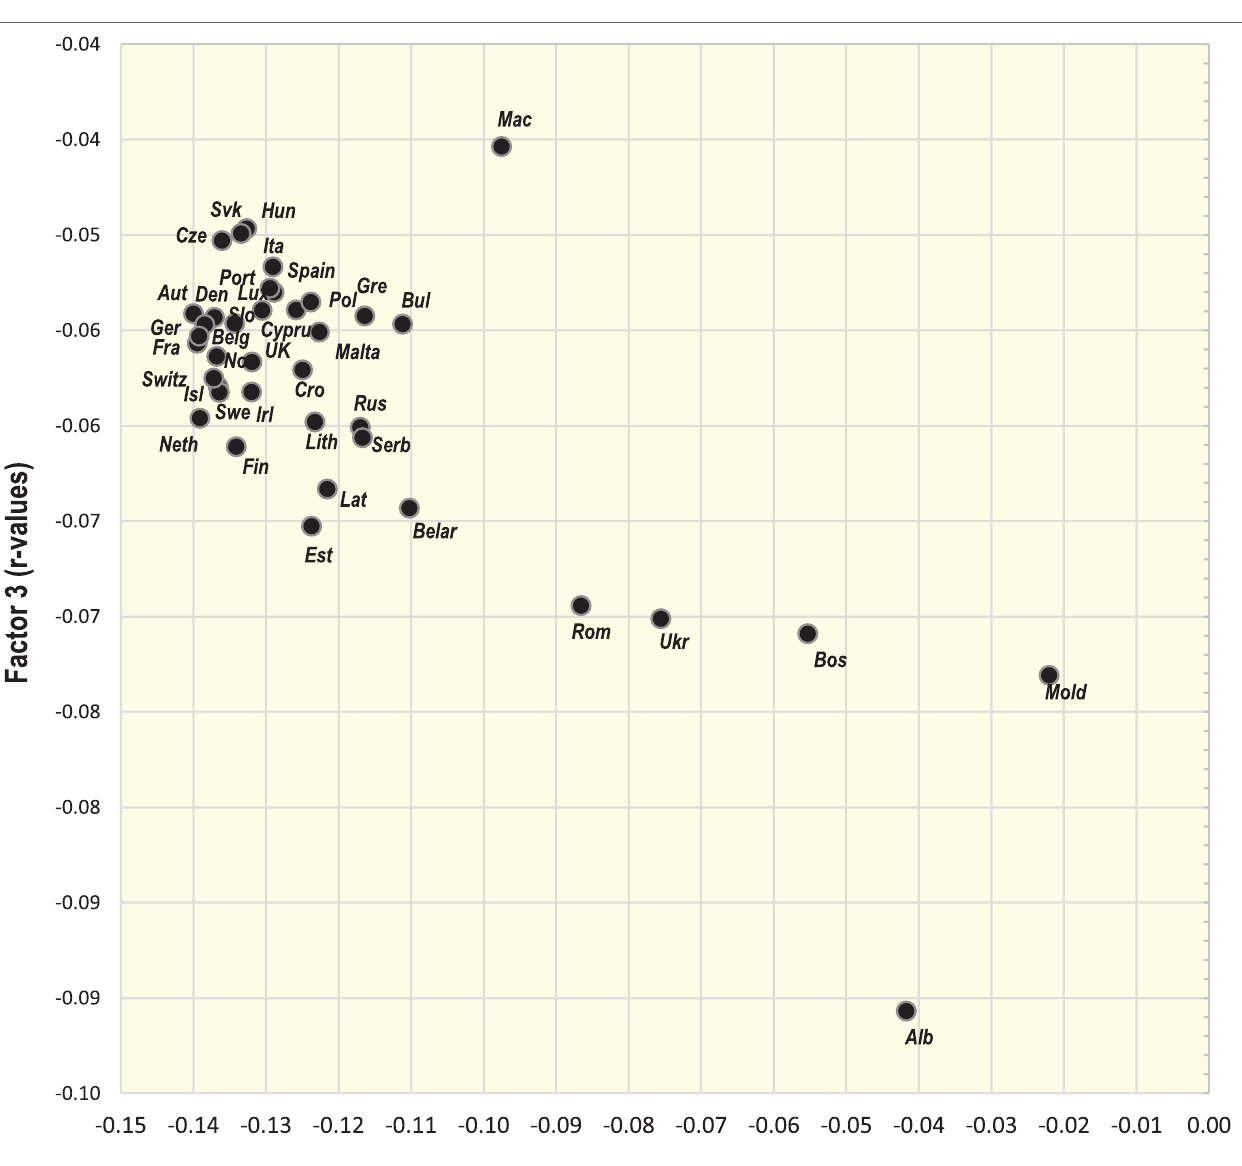
FigUre 10 | Projection of 39 countries on the factor plane of Figure 9